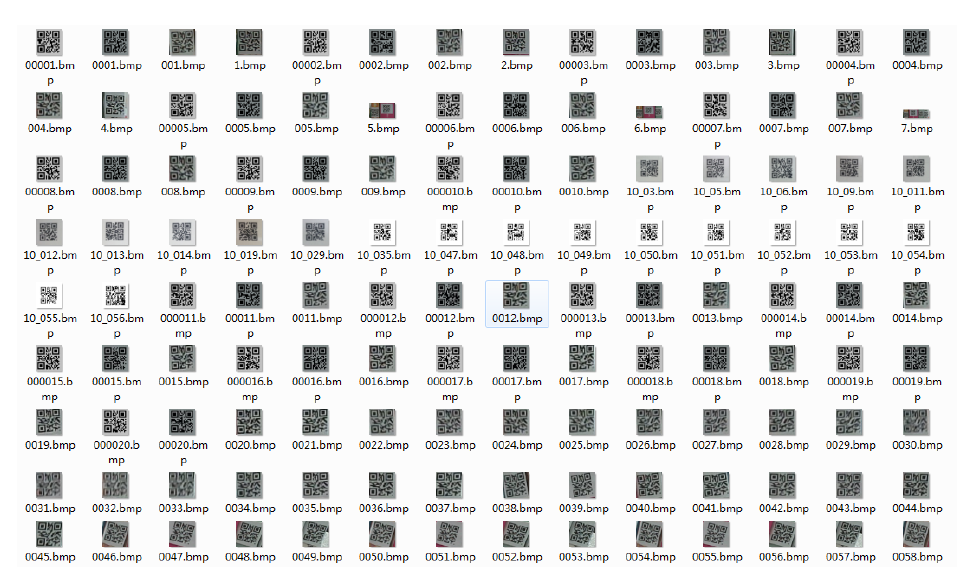
Figure 12. Part of the positive QR code image samples.